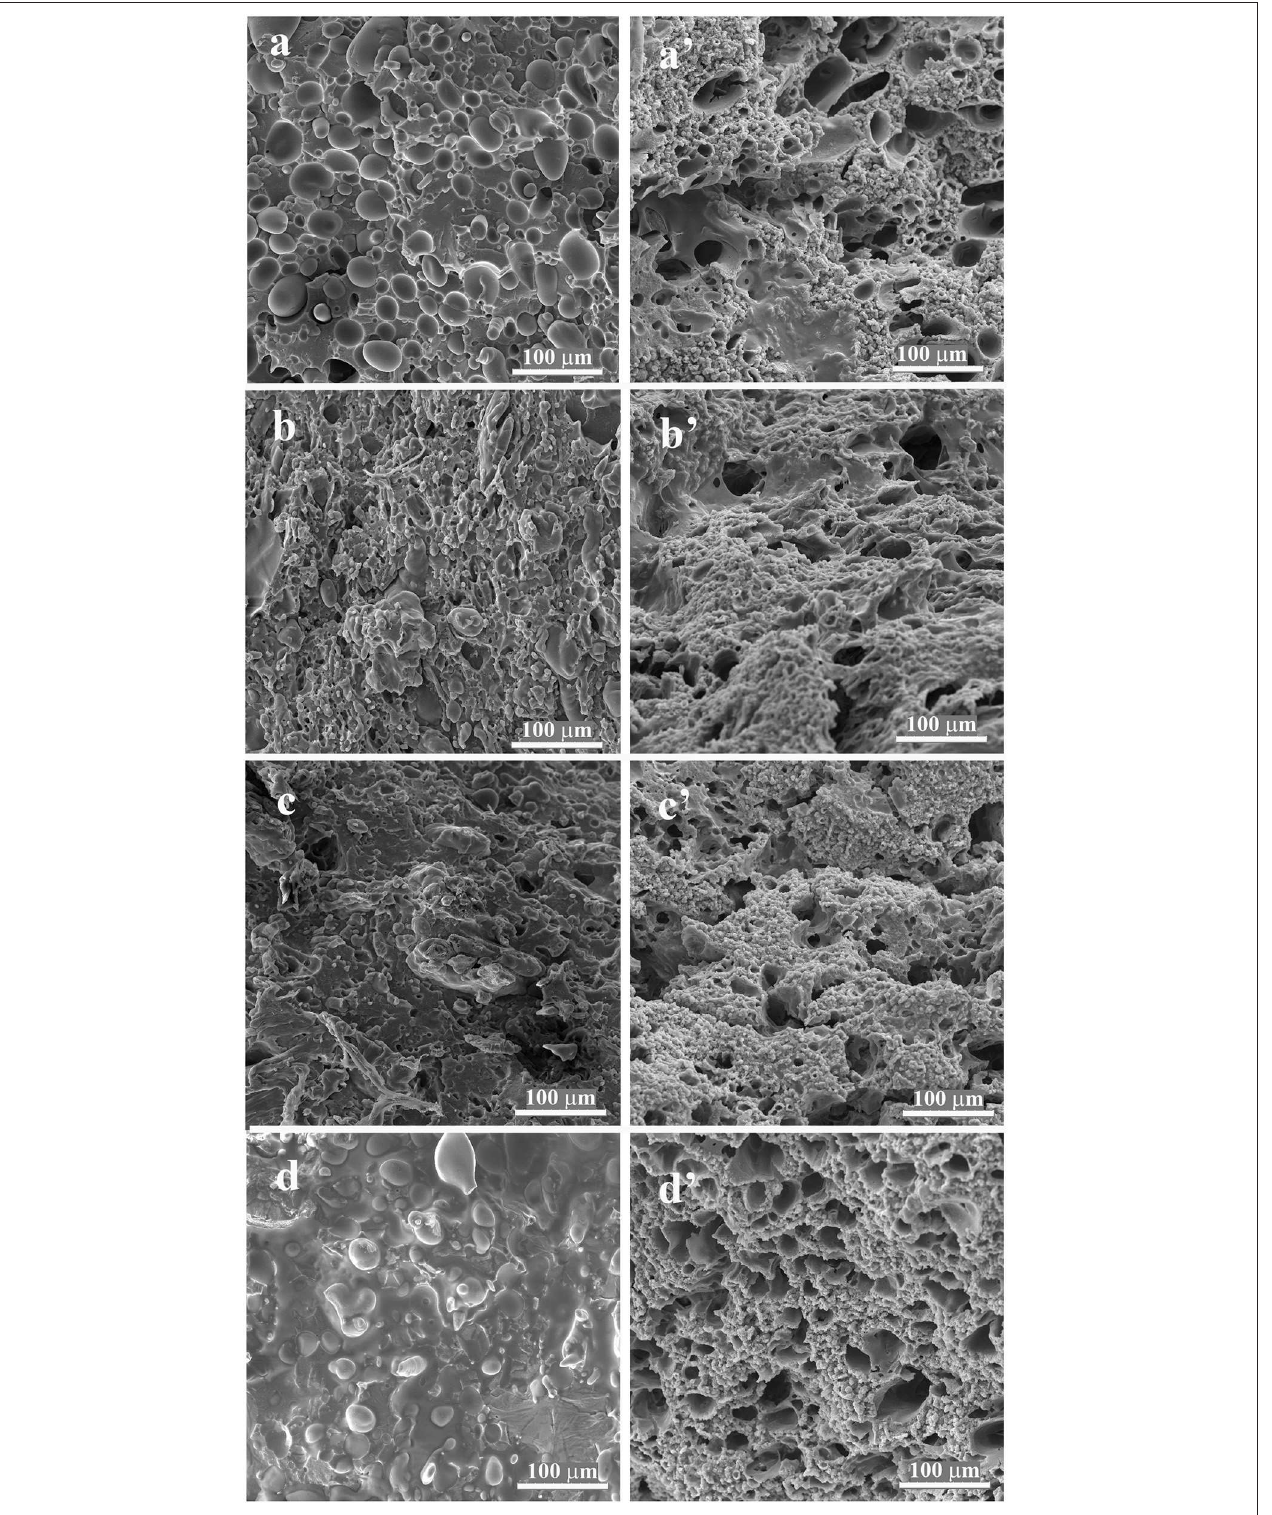
FIGURE 4 | SEM micrographs of non-etched surface of (a) PLA/EVA (60:40 wt%) blend and the composites containing (b) 1 phr of pCNT, (c) 6 phr of CNT/ILSO 3 H (1:5), and (d) 5 phr of ILSO 3 H (6 phr of CNT/ILSO 3 H corresponds to 1 phr of CNT in the system); and etched surface of the corresponding blend and composites (a’-d’)